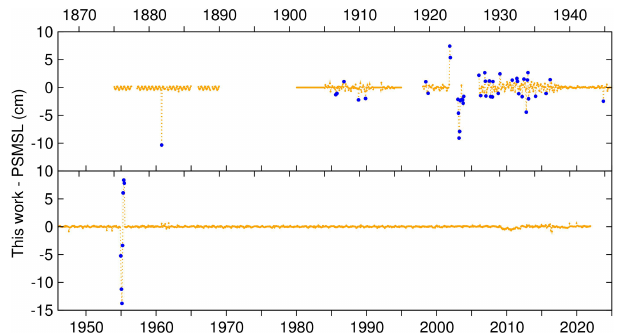
Figure C1. Differences between the monthly MSLs obtained in this work and those in the PSMSL database (cm). The blue dots high- light differences greater than 1cm in absolute value. The labels on the abscissa axes refer to the beginning of the